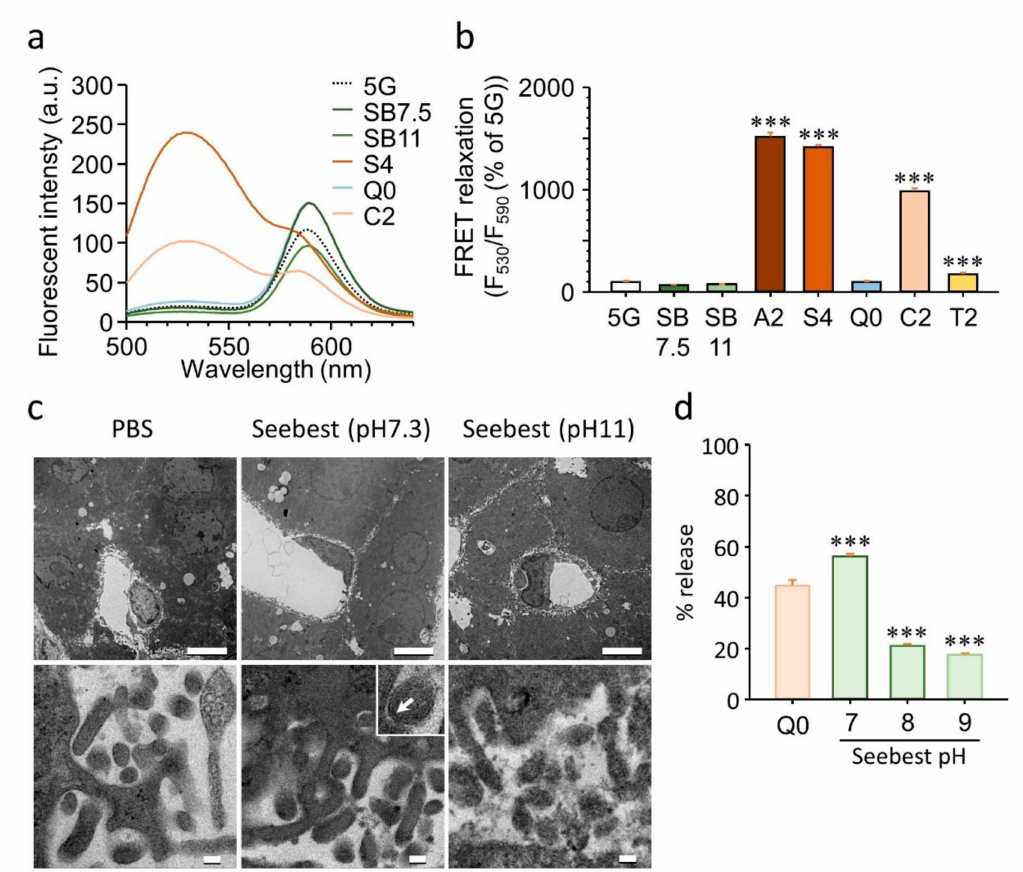
Figure 3. Assessment of lipid structures during tissue clearing. ( a ) Fluorescence spectra of Förster resonance energy transfer (FRET) liposomes in various tissue clearing solutions. ( b ) FRET relaxation of FRET liposomes by breaking lipid membranes. Moreover, 5G, 5% glucose; SB 7.5 and 11, Seebest pH 7.5 and 11; A2, Sca l eA2; S4, Sca l eS4; Q0, Sca l eSQ(0); C2, CUBIC reagent 2; T2, Clear T2 . Each bar represents the mean + S.D. of three experiments. Statistical comparison was performed using Dunnett’s test. The 5G group served as the control. *** p < 0.001 vs. control group. ( c ) Transmission electron microscopy. Liver specimens were subjected to transmission electron microscopy 1 day after incubation in Seebest. Eachimagewasrepresentativeofthreeexperiments. Scalebarsrepresent5 µ m(upperpanels)and0.1 µ m (lower panels). White arrow in the enlarged region of the lower panel of Seebest pH 7.3 indicates the lipid bilayer of the plasma membrane. ( d ) Release of dyes from phenolsulfonphthalein (PSP)-liposomes induced by tissue clearing solutions. Q0, Sca l eSQ(0). Each bar represents the mean + S.D. of three experiments. Statistical comparison was performed using Dunnett’s test. The Q0 group served as the control. *** p < 0.001 vs. control